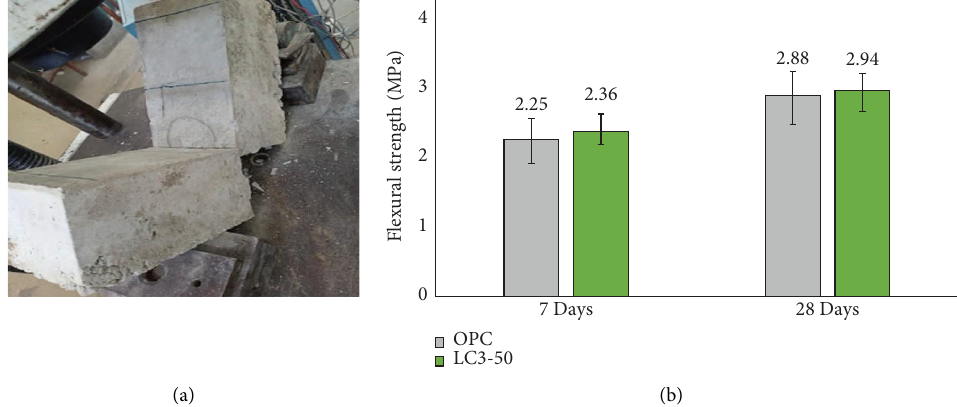
Figure 4: Results of the fexural strength test on 7 and 28days of curing. (a) Flexural strength test of the beam. (b) Results of fexural strength of beam cast from LC 3 -50 and OPC concrete.